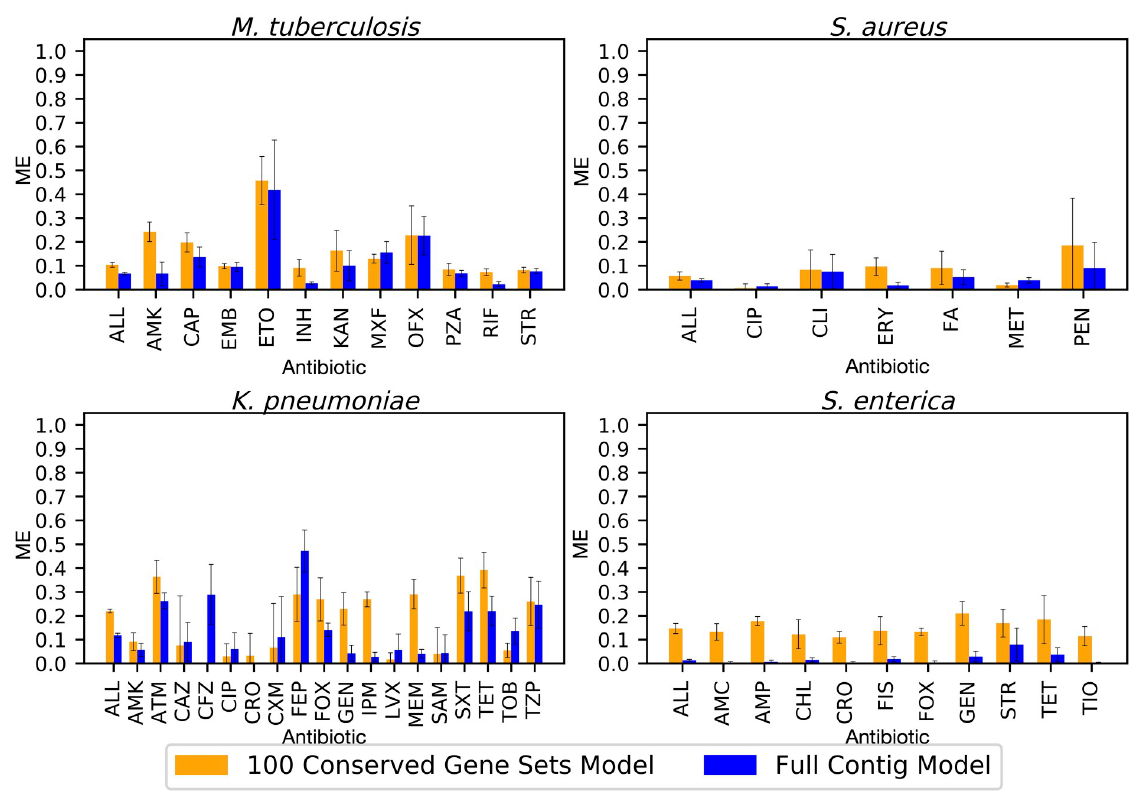
Fig 4. Average major error rate (ME) by antibiotic for ten models built from non-overlapping sets of 100 randomly-selected core genes (orange bars) compared with the ME for models built from whole assembled contigs (blue bars). MEs are defined as susceptible genomes being incorrectly classified as resistant. Error bars represent 95% confidence intervals for the whole genome model, and the minimum and maximum confidence interval observed in all ten replicates for the core gene models. Antibiotic abbreviations are defined in Table 2.